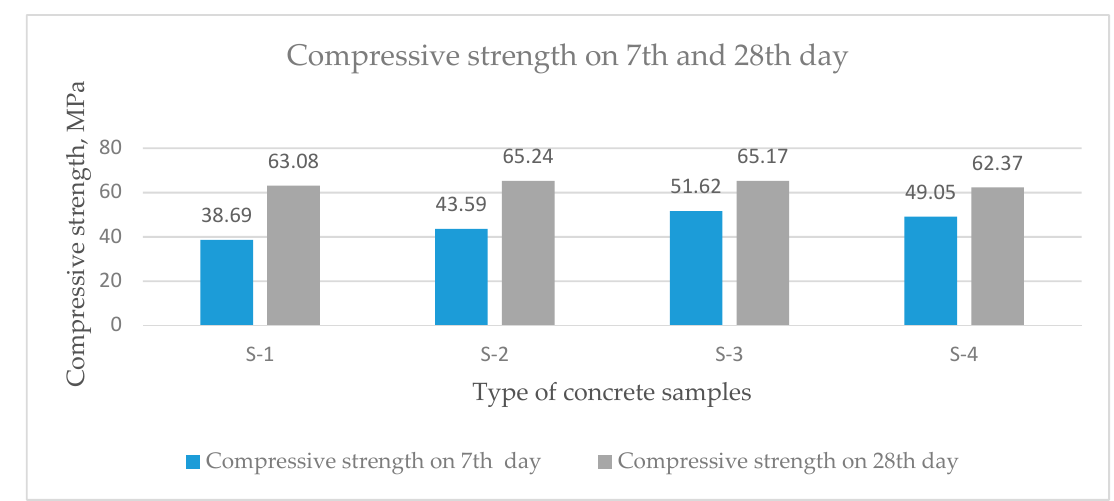
Figure 3. Compressive strength of concrete samples on the 7th and 28th days.